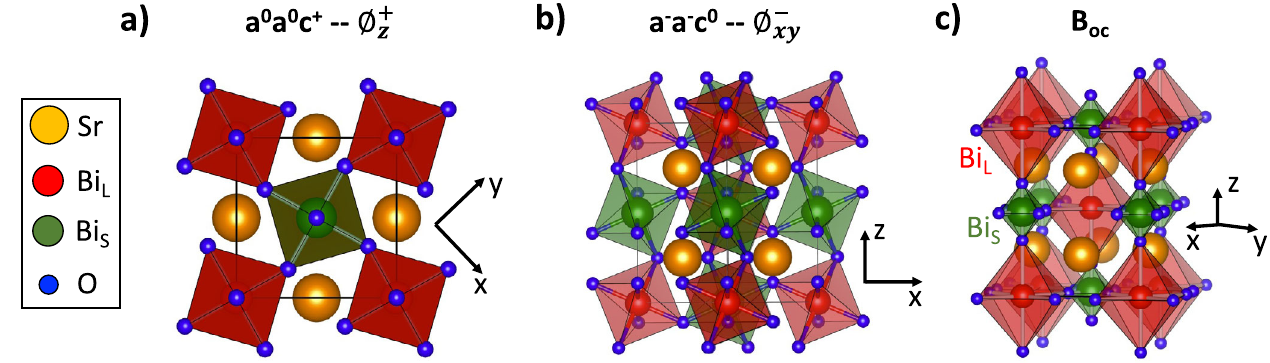
Fig. 1 Structural distortions displayed by SrBiO 3 and BaBiO 3 in the P2 1 /n ground state phase. a In-phase rotation a 0 a 0 c + ( ; þ z-axis. b Anti-phase rotation a - a - c 0 ( ; (cid:2) ) around the x and y axes. c Breathing distortion B oc splitting Bi sites into two different xy